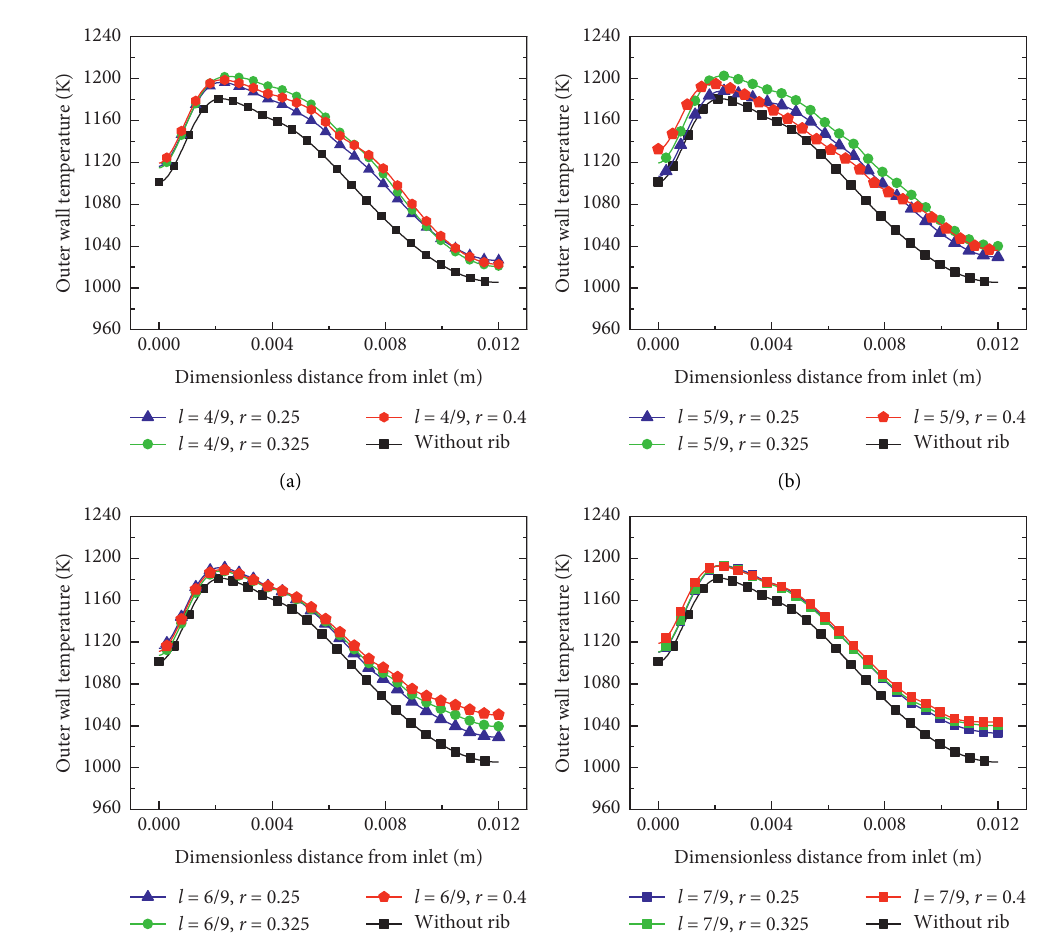
Figure 7: Outer wall temperature at different rib positions and